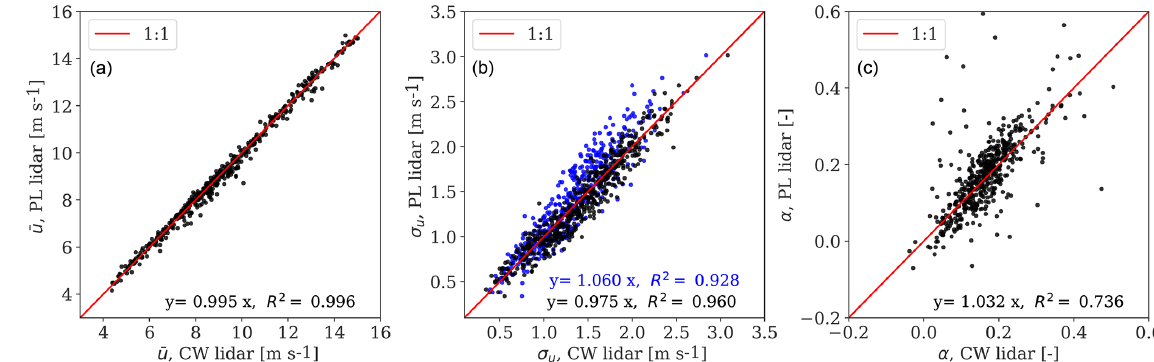
Figure 8. Comparison of the CW and PL lidar 10min reconstructed wind speed (a) , filtered and unfiltered turbulence in black and blue colour, respectively (b) , and shear exponent (c) for partial-wake conditions. We show a 1 : 1 line for guidance, the slope of a linear regression model, and the coefficient of determination R 2 .